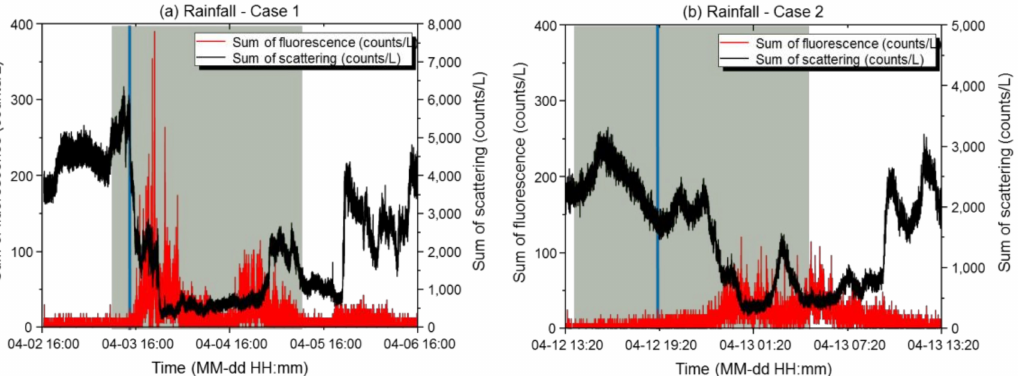
Figure 4. Results of scattered light and fluorescence measurements with the biological particle detector during rainfall. ( a , b ) Time-dependent concentrations of light scattering and fluorescent particles in Case 1 ( a ) and Case 2 ( b ). The X-axis represents the measurement period, and the Y-axis represents the measured particle concentrations. The black line represents the scattered light sum (counts/L), the red line represents the fluorescence sum (counts/L), the blue line represents the time of maximum rainfall, and the green line represents the time period when the meteorological condition occurred during the measurement